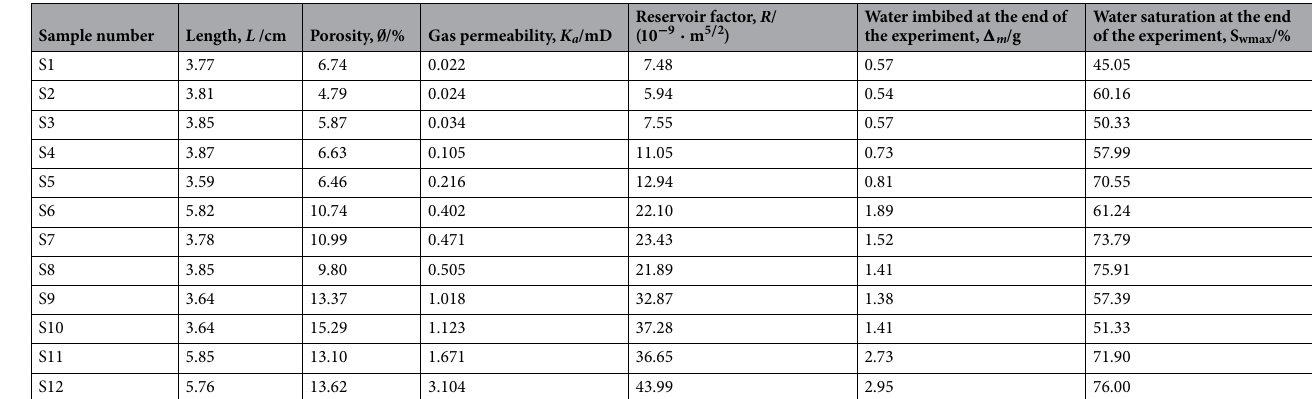
Table 1. Basic parameters and partial experimental results of sandstone samples.